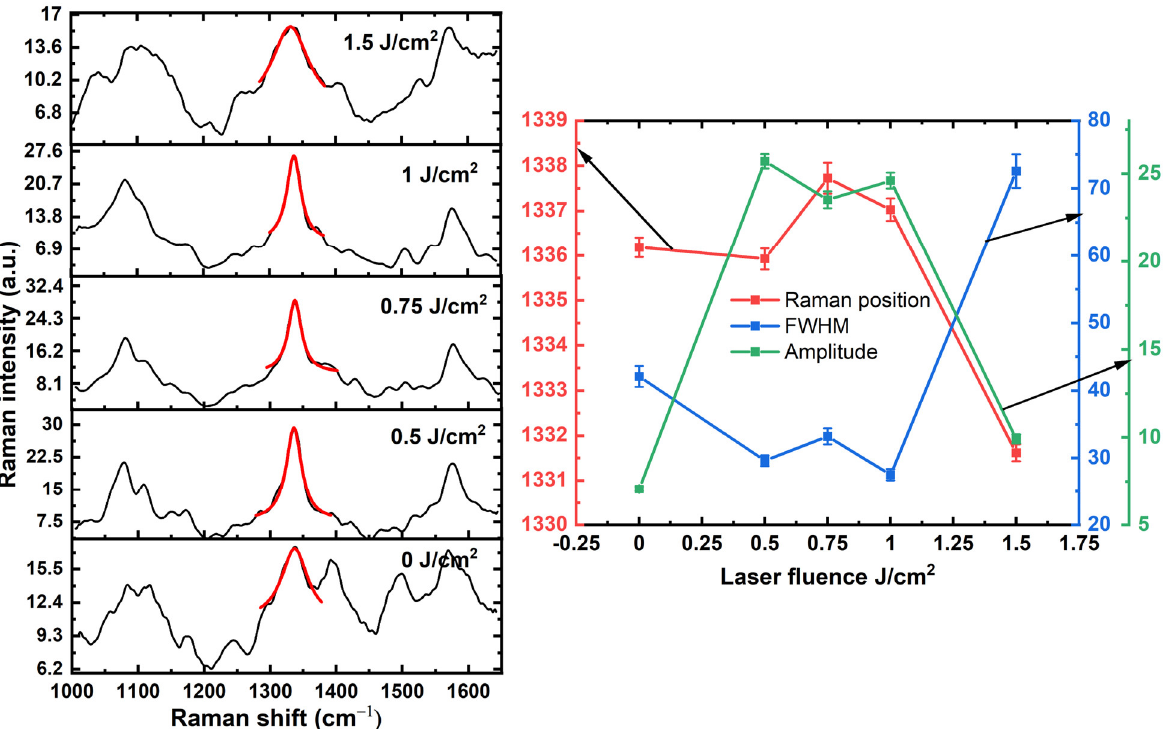
Figure 4. On the ( left ): Raman spectra taken from different areas of Pd with a thickness 17.6 nm irradiated with various laser fluence values (0 J/cm 2 , 0.5 J/cm 2 , 0.75 J/cm 2 , 1 J/cm 2 , 1.5 J/cm 2 ), the peak located at 1340 cm − 1 adjusted with a Lorentzian function (red curve); on the ( right ): extracted parameters (Amplitude, Raman peak position, FWHM) from the adjustment with the Lorentzian function versus laser